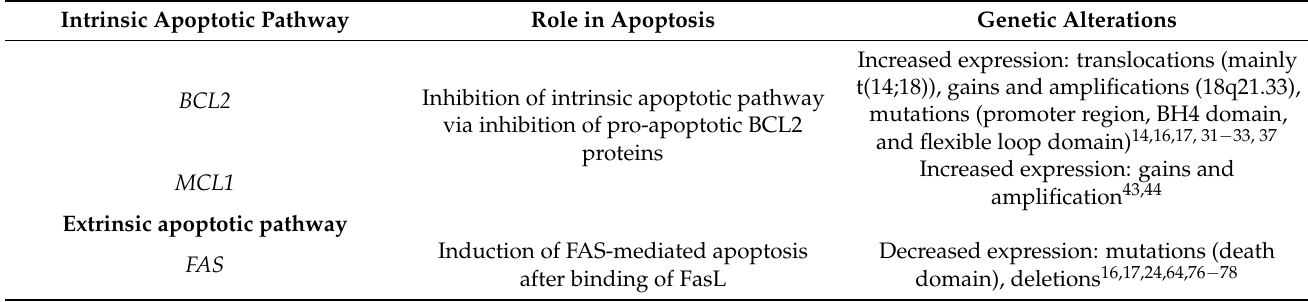
Figure 1. Simplified Overview of Apoptosis in DLBCL, BCR: B cell receptor, Cytc: cytochrome C, DISC: death-inducing signaling complex, IAPs: inhibitor of apoptosis proteins. Created with BioRender.com. Table 2. Main Genetic Events Inhibiting Apoptosis in